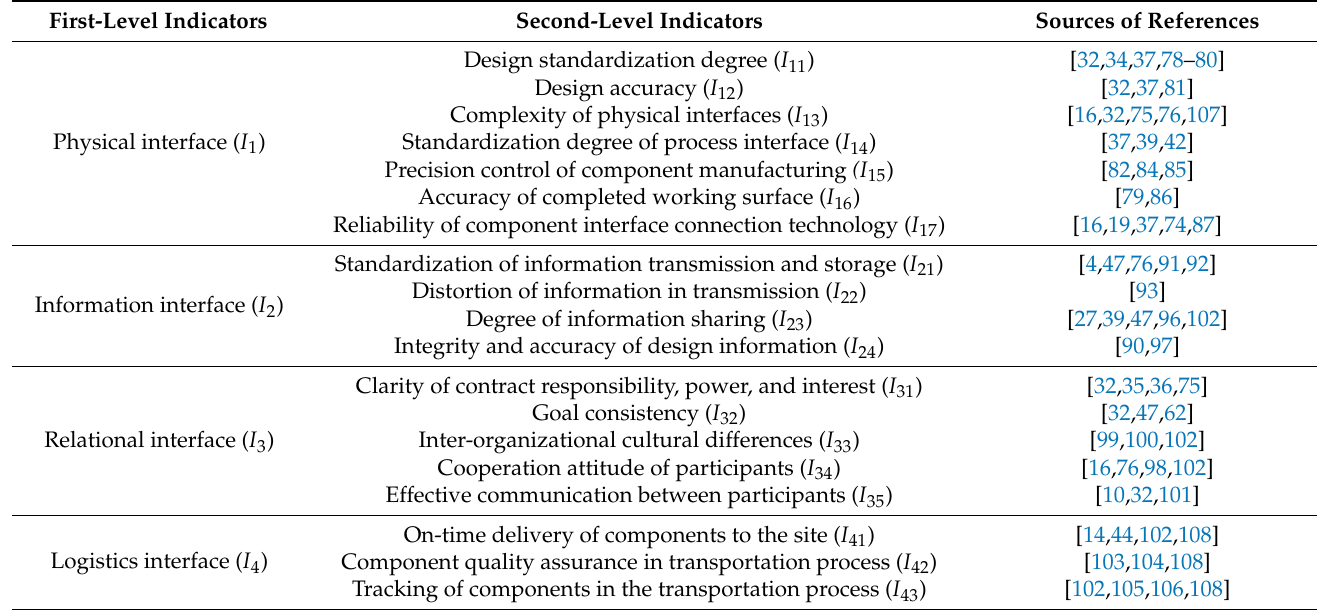
Table 1. IM performance assessment indicator system of PC